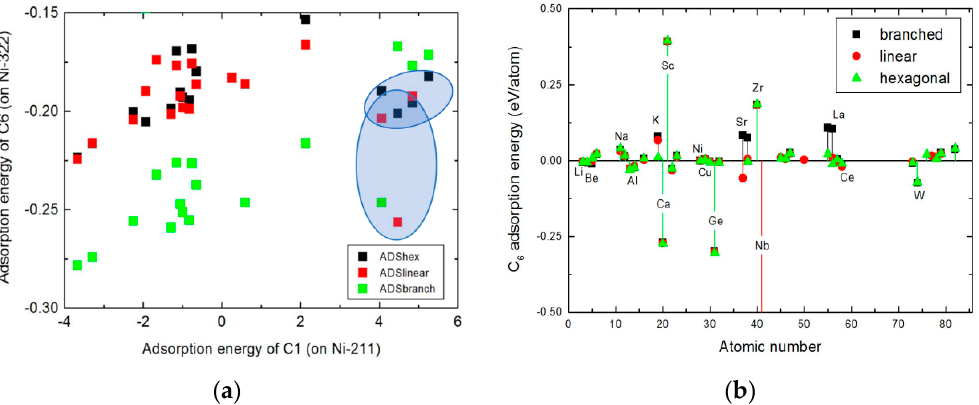
Figure 6. The correlation between the adsorption energies of C 6 fragments of hexagonal, linear, and branched geometries and the single adatom (C 1 ) species ( a ). Influence of surface dopants on the adsorption energy of polymerized C 6 cluster ( b ).